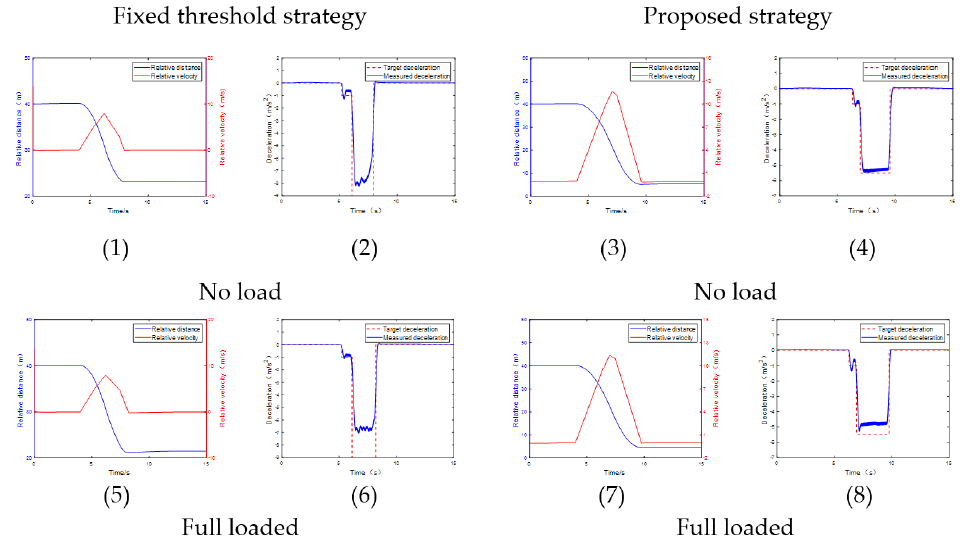
Figure 21. Comparison of experimental results for the CCRb scenario.